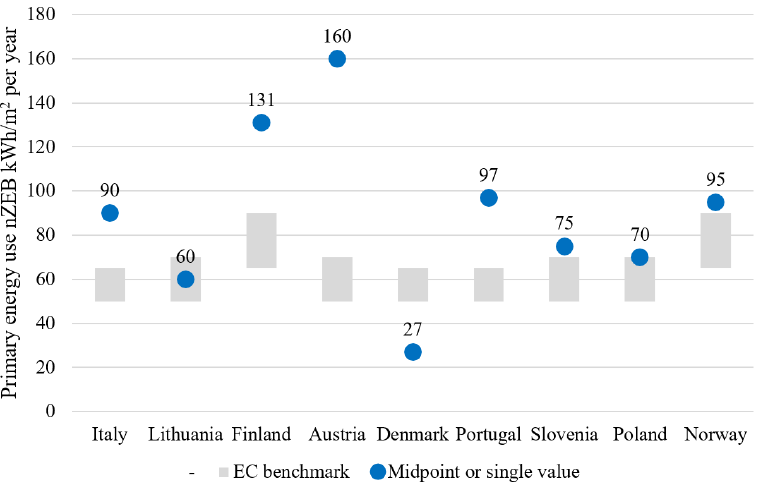
Figure 1. NZEB values (kWh/m 2 /year) for single-family homes in European countries analyzed.